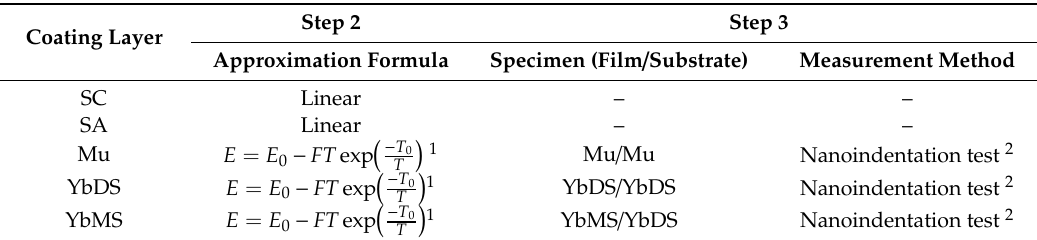
Table A2. Detail of estimation procedure of E of SiC, SiAlON, mullite, YbDS and YbMS layers (Steps 2 and 3).